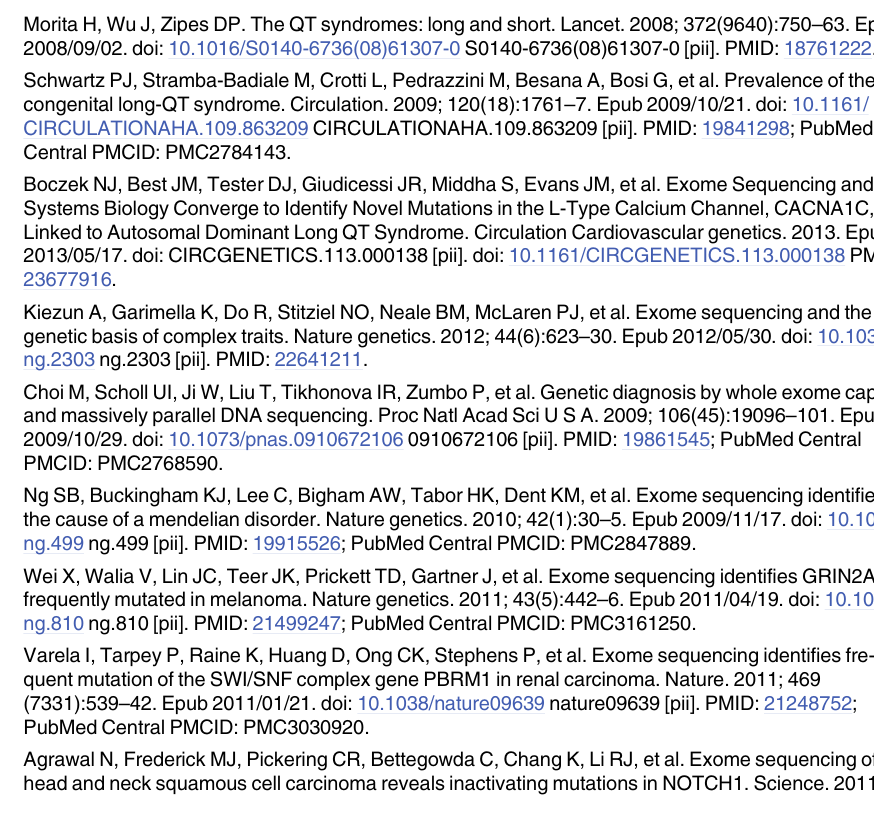
S2 Table. Variants detected in each of the 35 probands. † NS: non-synonymous SNV, SP: splice-site SNV. (cid:1) Confirmed candidates: candidates co-segregated in the pedigree and vali- dated using Sanger sequencing. S3 Table. Potential pathogenic mutations detected in 23 of the 35 families. † AR: autosomal recessive (HMZ = homozygous, CHTZ = compound heterozygous), AD: autosomal dominant. Bold: LQTS-susceptibility